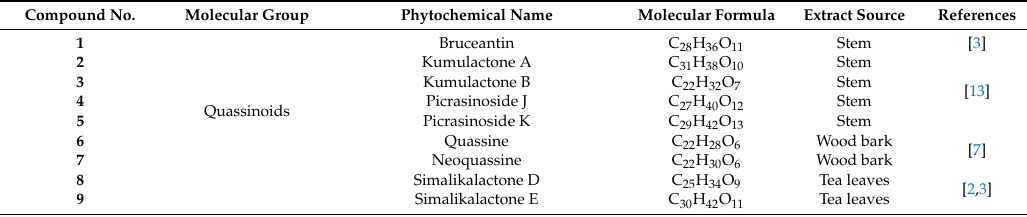
Table 1. Phytochemicals available in Picrasma quassioides